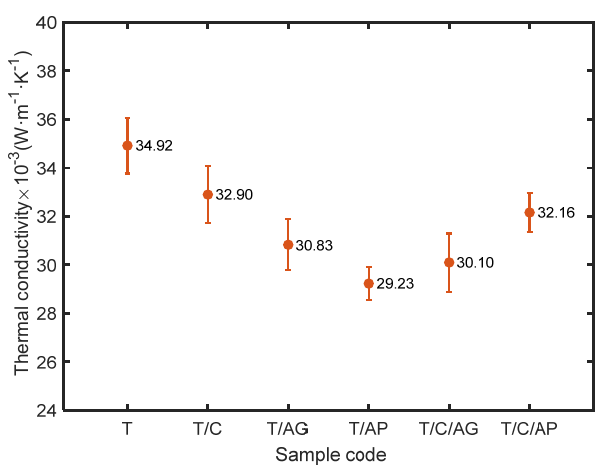
Figure 8. Thermal conductivity of the electro-sprayed materials.